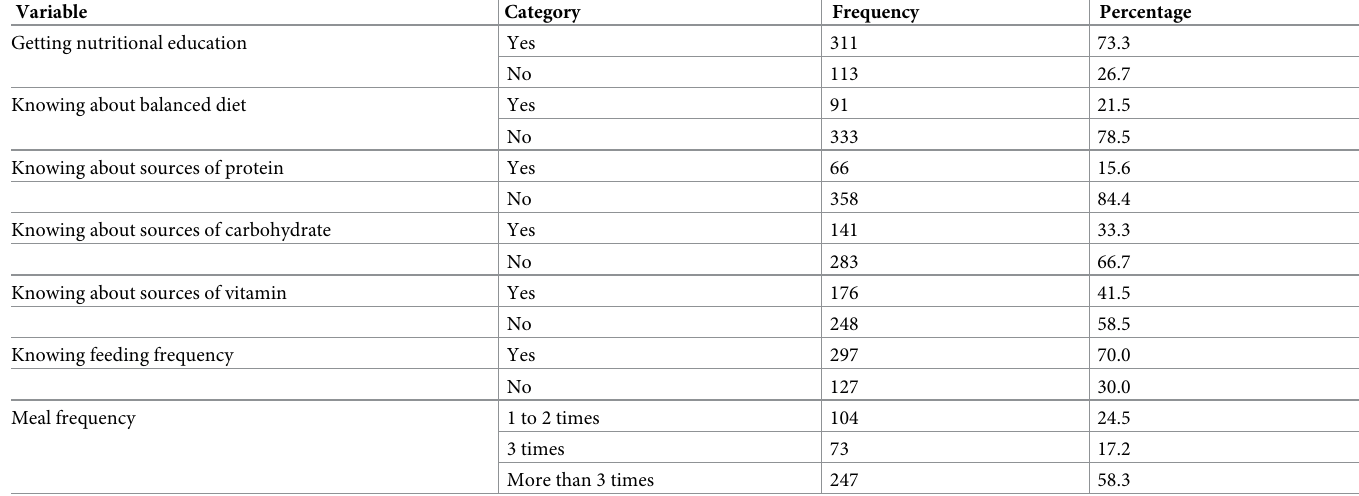
Table 2. Nutritional knowledge and feeding habit of pregnant women (n = 424) attending antenatal clinics of Konso Zone public health facilities, Southern Ethio- pia, 2020. Variable